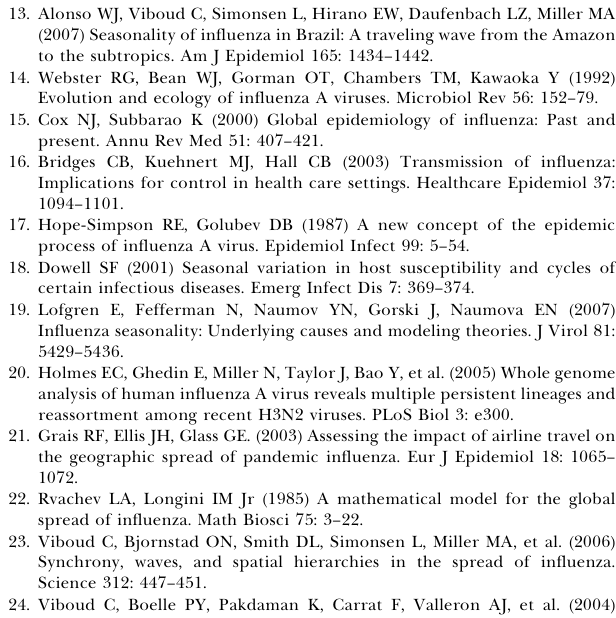
Figure S1. Phylogenetic Relationships of the PB2 Gene Segment of A/ H3N2 Influenza Viruses Sampled from New York State ( n ¼ 52), New Zealand ( n ¼ 51), and Australia ( n ¼ 45) from 1998–2005, Estimated Using ML Method Viral isolates from New York state are highlighted in orange, isolates from New Zealand in green, isolates from Australia in blue, and global isolates in pink. Light yellow rectangles identify viral clades, with numbers in white boxes giving bootstrap values for key nodes ( . 70%). Capital letters in blue refer to clades that appear in section I of the tree (denoted in pink) on the phylogeny of the concatenated six non-surface glycoprotein segments; lowercase letters in red refer to clades contained within section II (denoted in light green); lowercase roman numerals in dark green refer to clades outside sections I and II. Bootstrap values highlighted in yellow identify nodes that define a cross-hemisphere migration event. The tree is rooted by isolate A/New York/327/1999 from the 1998–1999 season (i.e., the earliest sampled isolate), and all horizontal branch lengths are drawn to a scale of nucleotide substitutions per site. Found at doi:10.1371/journal.ppat.0030131.sg001 (975 KB EPS). Figure S2. Phylogenetic Relationships of the PB1 Gene Segment of A/ H3N2 Influenza Viruses Sampled from New York State ( n ¼ 52), New Zealand ( n ¼ 51), and Australia ( n ¼ 45) from 1998–2005, Estimated Using ML Method Color scheme, rooting, scale, and symbols are the same as those used in Figure S1. Figure S3. Phylogenetic Relationships of the PA Gene Segment of A/ H3N2 Influenza Viruses Sampled from New York State ( n ¼ 52), New Zealand ( n ¼ 51), and Australia ( n ¼ 45) from 1998–2005, Estimated Using ML Method